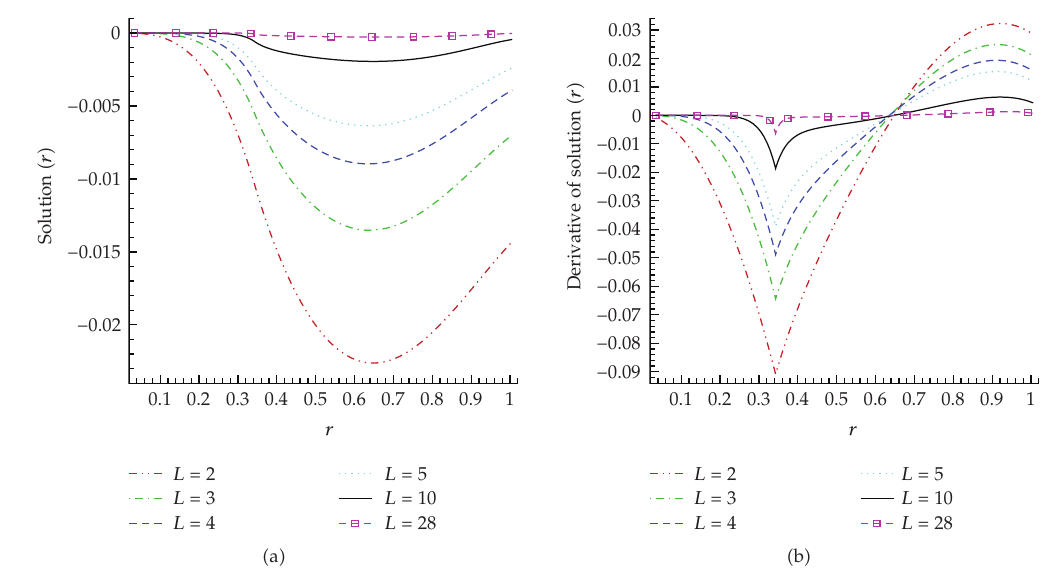
Figure 6: Comparisons of the solution φ (cid:6) a (cid:7) and the derivative of the solution ∂φ/∂r (cid:6) b (cid:7) for the sample geodynamo problem. Results were obtained from the sixth-order compact schemes with the Jacobian transformation at di ff erent values of L